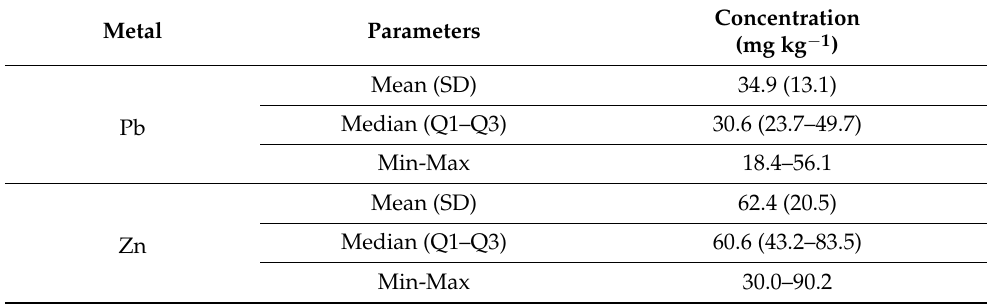
Table 2. Mean concentrations, standard deviations, median (Q1–Q3) and min-max of heavy metals in the soils in mg kg − 1 ; n = 72. Table 2. Cont.